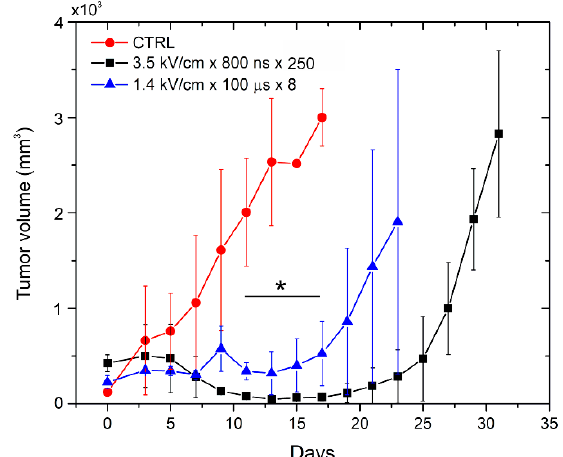
Figure 5. Dynamics of tumor growth after treatment with pulsed electric fields and doxorubicin, where the asterisk corresponds to the statistically significant difference ( p < 0.05) versus CTRL—untreated control.